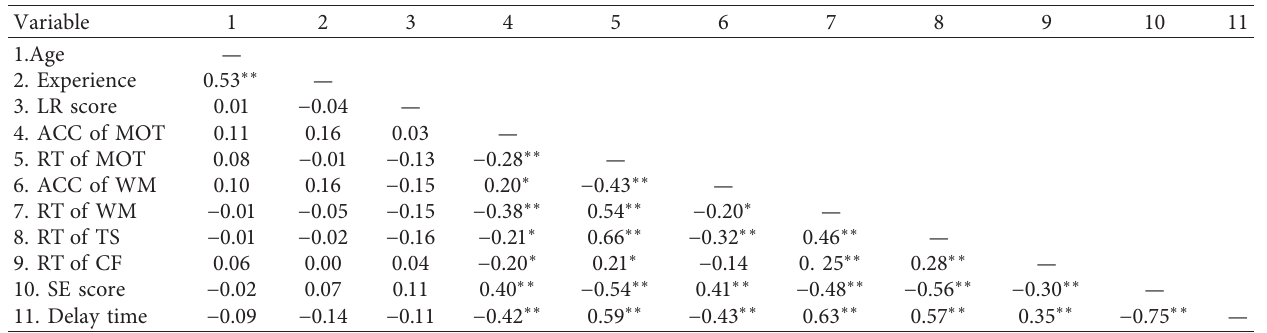
Table 3: Correlation between variables.